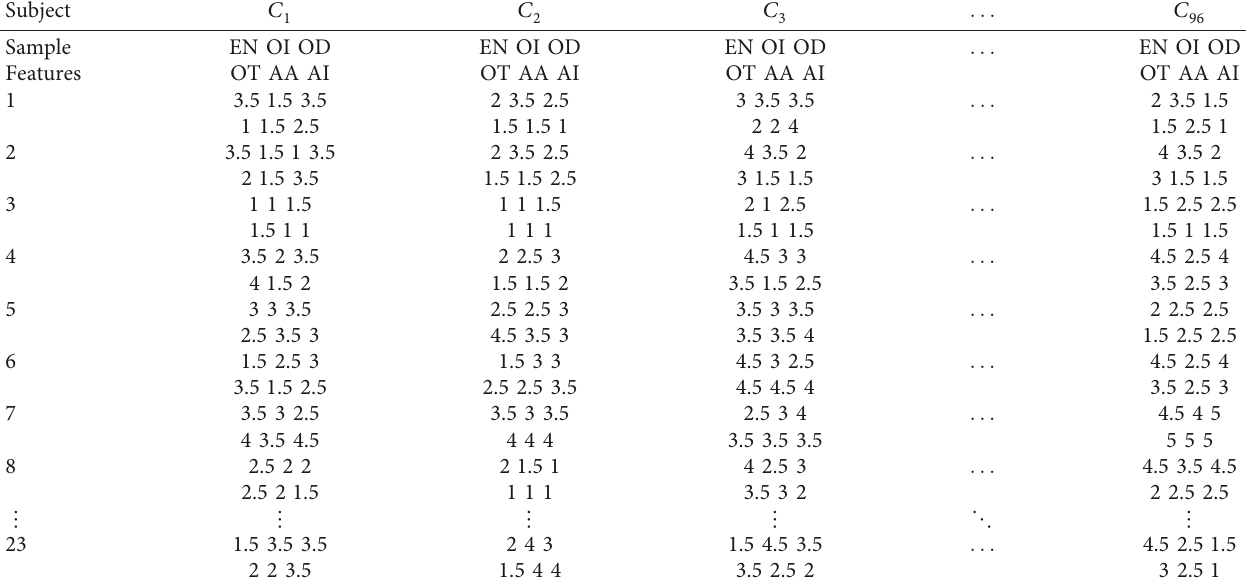
Table 4: Hesitant-fuzzy evaluation matrix.